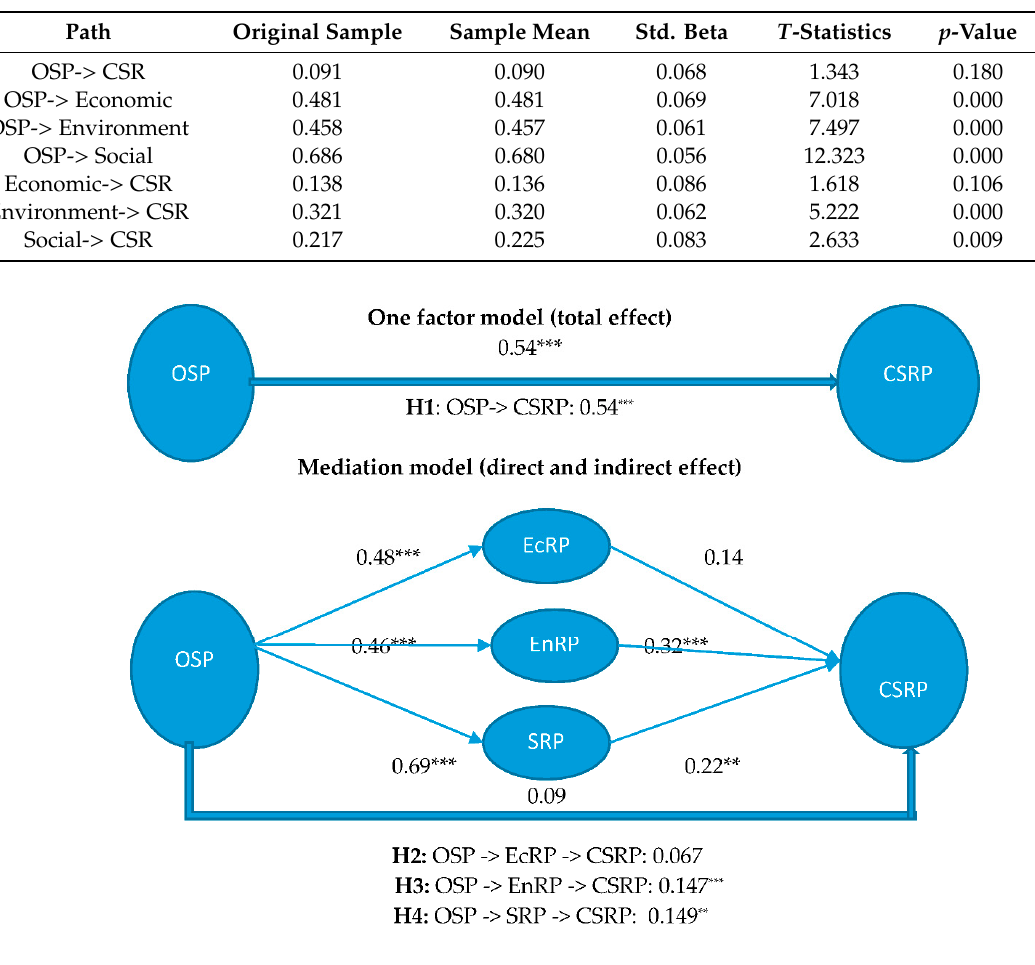
Table 8. Path coefficient and T statistics of direct effects. Table 8. Path coe ffi cient and T statistics of direct e ff ects.